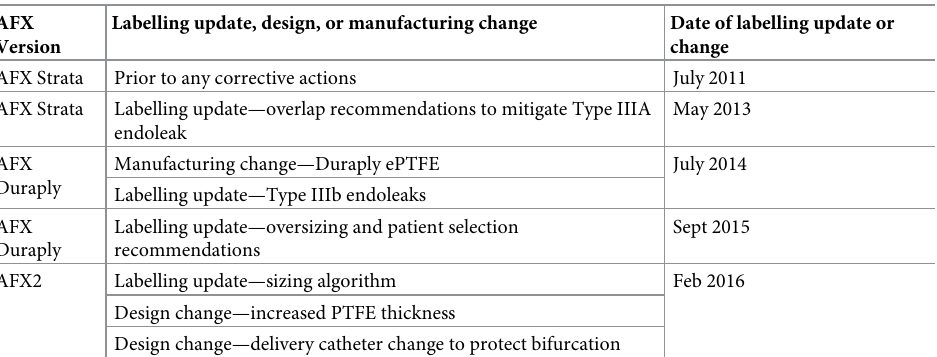
Table 2. AFX endografts.